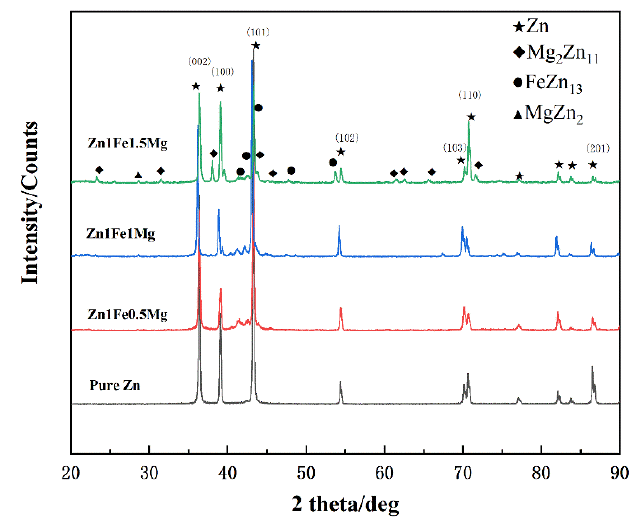
Figure 2. The comparison of XRD patterns of Zn1FexMg alloys. Table 2. Grain sizes of alloys and FeZn13 phase size of alloy samples.